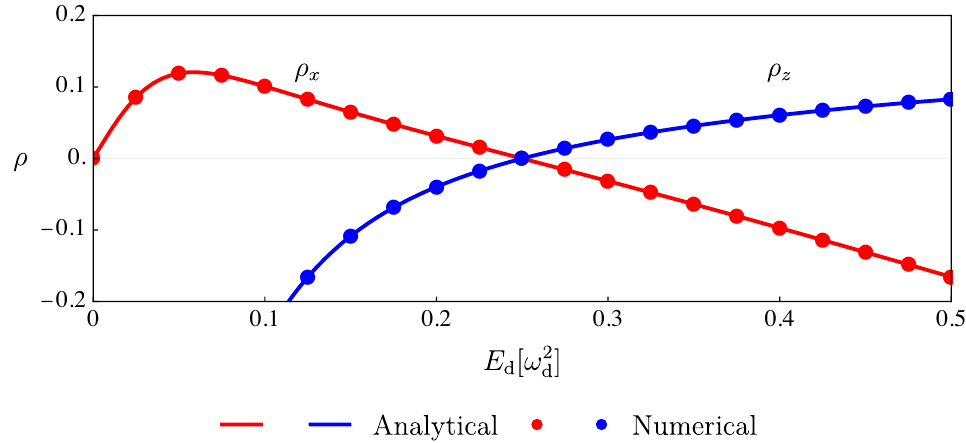
Figure 5: A comparison between the analytical (solid lines) and numerical (dots) results of the dissipative two-level steady state components ρ = ω / 2. The zero-crossing of ρ for λ = 0. It is ω z d state population inversion in Fig. 3